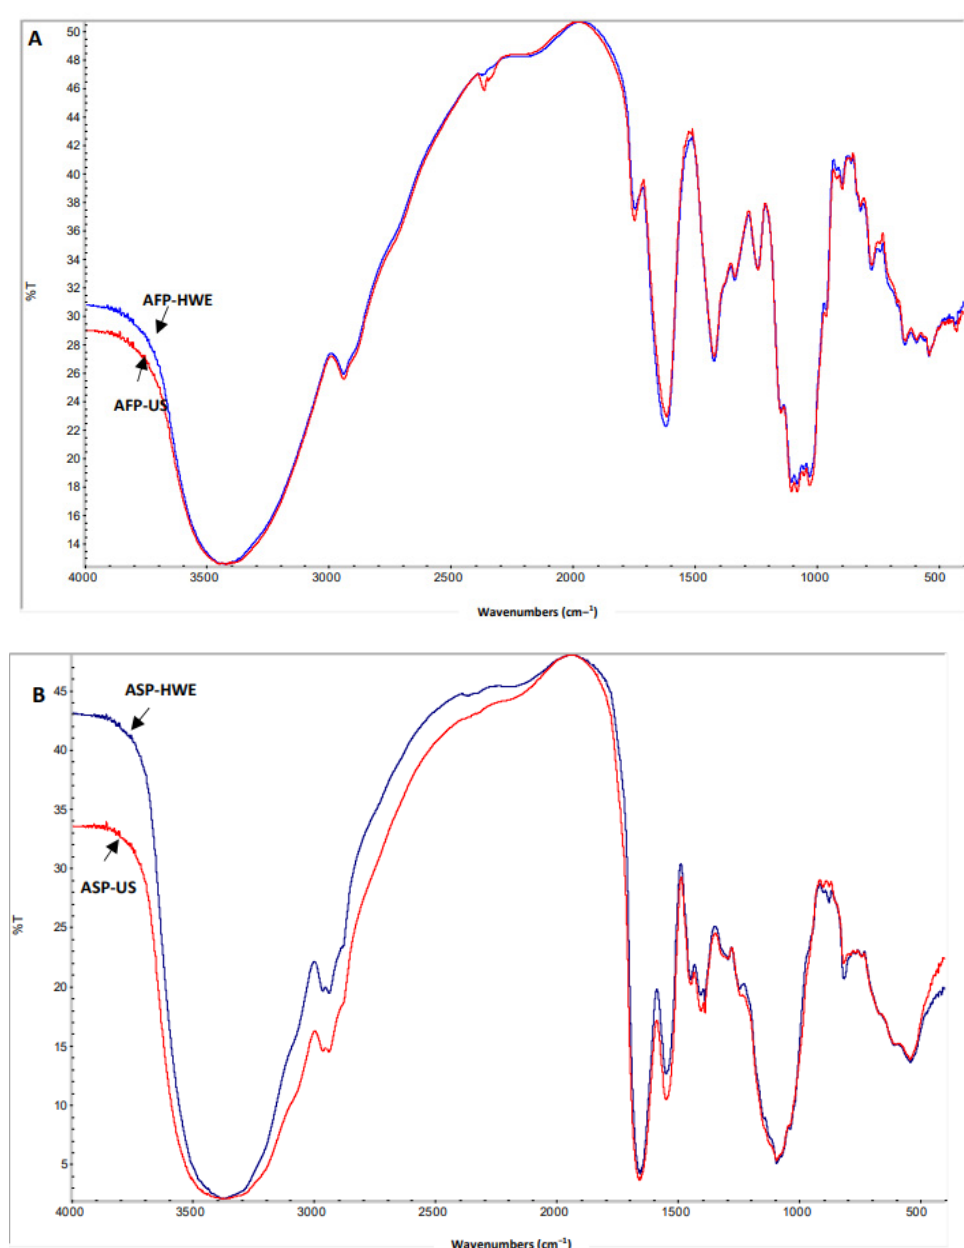
Figure 1. Infrared spectroscopy of polysaccharides extracted from Ajwa flesh ( A ) and Ajwa seed ( B